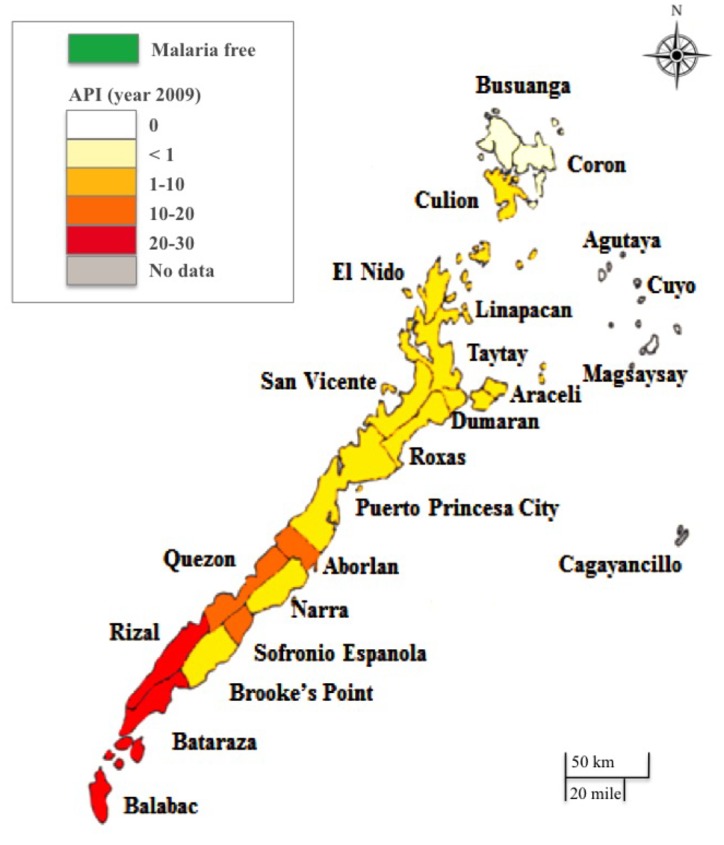
Map of Annual Parasite Incidence (API) (confirmed infections/1,000 population at risk) by municipalities, 2010.This map was constructed by the authors based on the data of provincial health report 2010 [5].